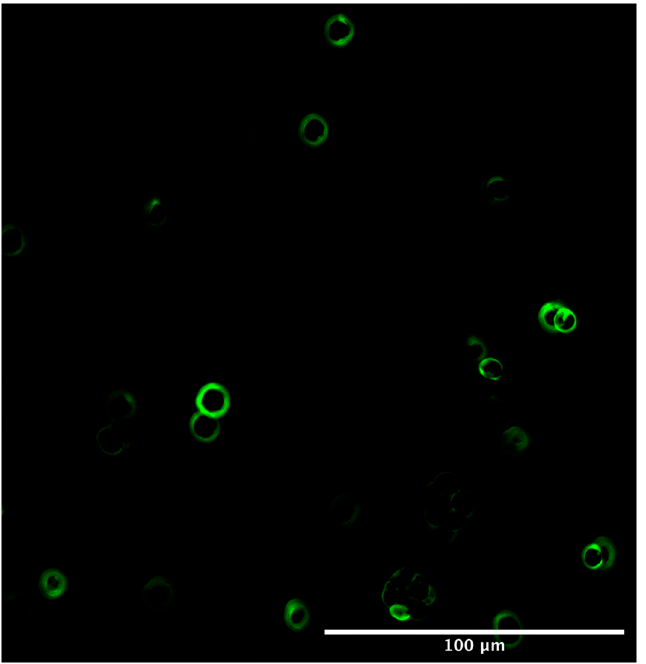
Figure 6. Laser Confocal Microscopy Image of the cellulose-only channel with CT480 of initial native biomass.